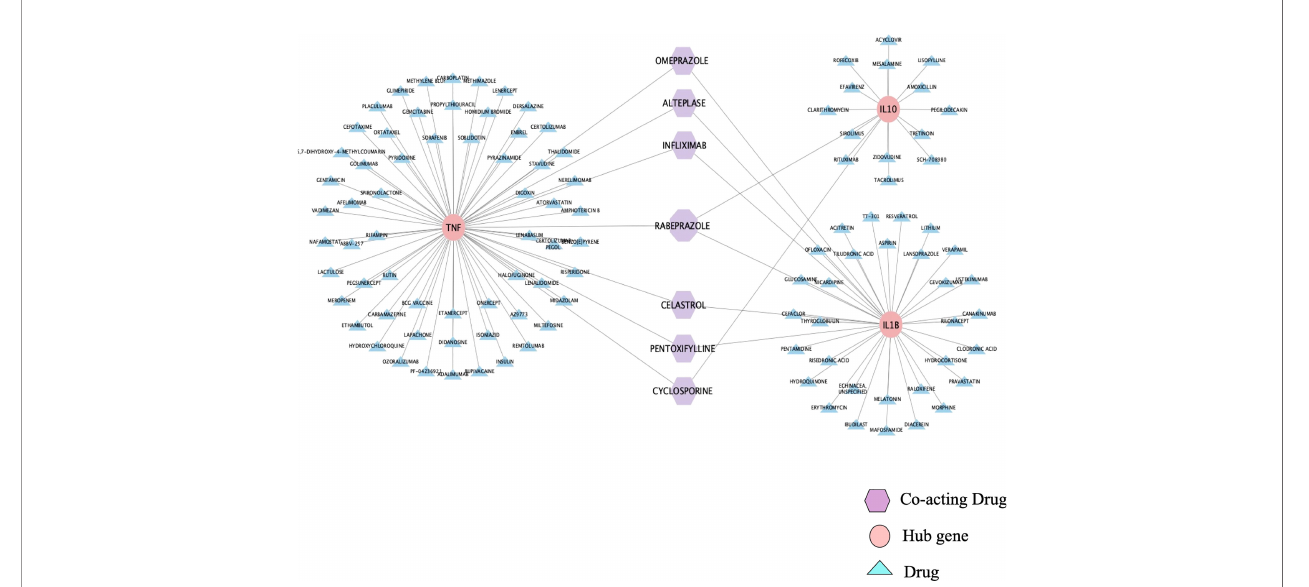
FIGURE 6 | Drug-Gene Interaction. DGIdb database predicted six drugs acting on two hub genes and one drug acting on three hub genes. The pink represents the hub genes, the purple represents drugs that co-act on the hub genes, and the blue represents drugs that only act on one hub